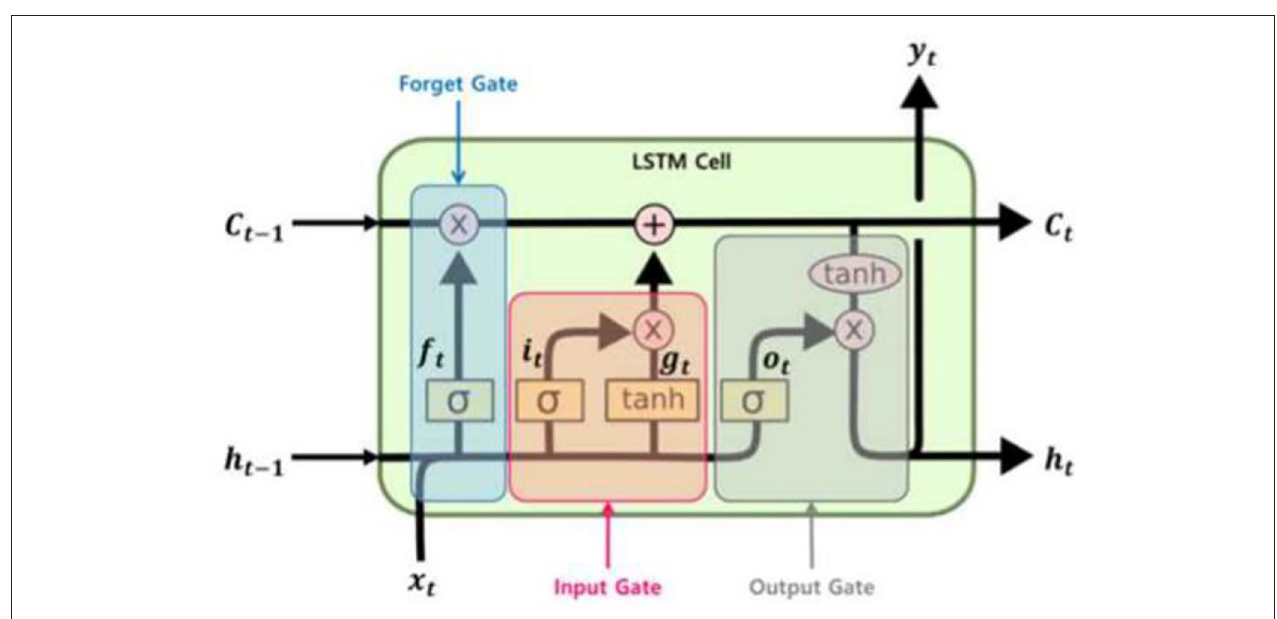
FIGURE 6 | Structure of long-short term